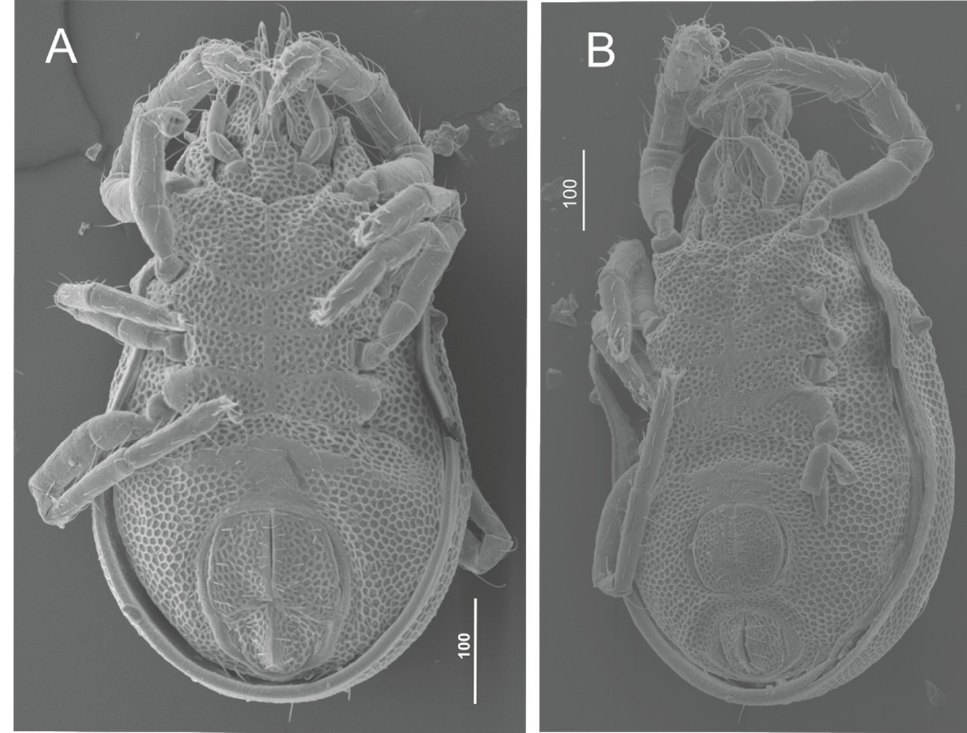
Figure 3. Ventral side of the female ( A ) and male ( B ).